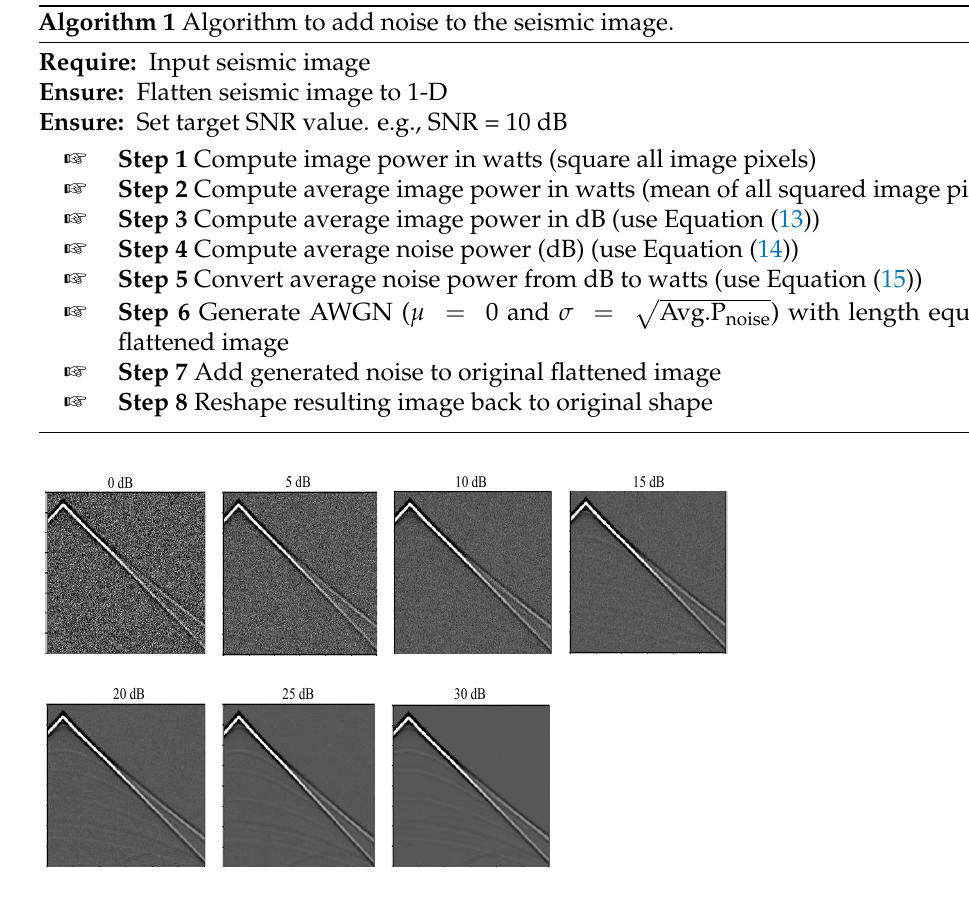
Figure 6. Seismic image representation at each noise level.